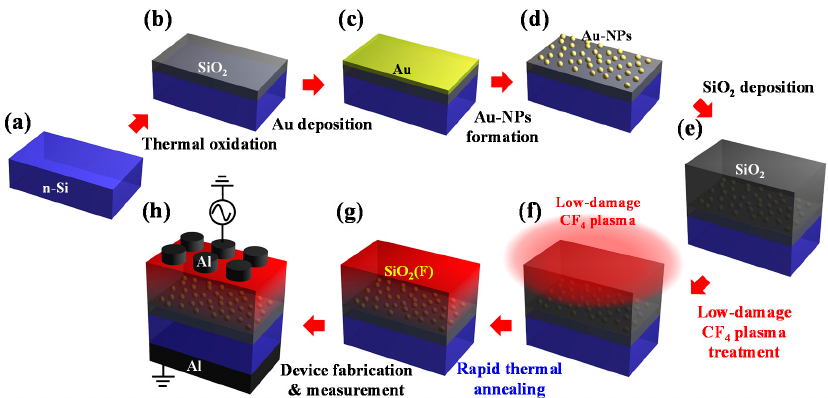
Figure 1. Fabrication procedures of the gold-nanoparticle (Au-NP) non-volatile memories (NVMs) with low-damage CF 4 plasma treatment on the blocking oxide (BO) layer. ( a ) n -type Si (100) wafers with standard Radio Corporation of America (RCA) clean; ( b ) thermally grown SiO 2 film; ( c ) physical-vapor-deposition (PVD)-deposited Au film; ( d ) rapid thermal annealing (RTA) to form Au-NPs; ( e ) plasma-enhanced chemical vapor deposition (PECVD)-deposited SiO 2 film; ( f ) low-damage CF 4 plasma treatment; ( g ) RTA to activate fluorine ions; and ( h ) Al contact formation to fabricate Au-NP NVMs.